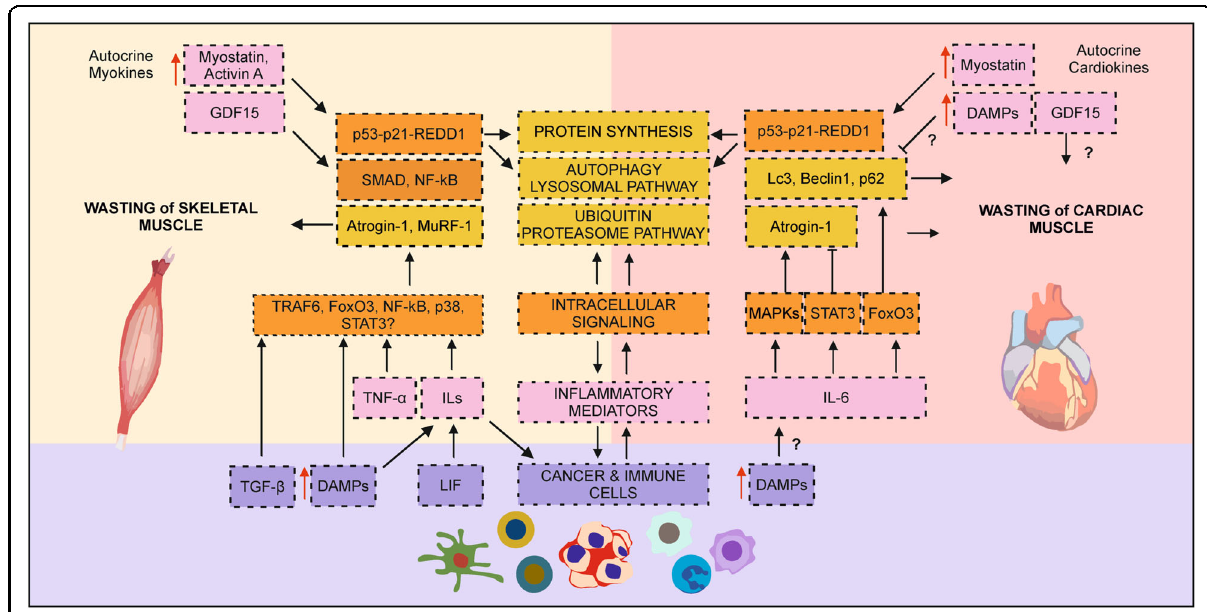
Fig. 2 Pathological alterations underlying muscle wasting in cancer cachexia. The mechanisms underlying cancer cachexia are multiple and intertwined. Either factors released by skeletal and cardiac muscles (myokines and cardiokines respectively; pink boxes) or factors secreted by cancer and cancer-associated immune cells (violet boxes) trigger a cascade of processes which ultimately result in cachexia. The circulating factors (pink), intracellular signaling pathways (orange), and fi nal effectors of wasting (yellow) that lead to skeletal (left side of the fi gure) and cardiac (right side of the fi gure) muscle wasting are reported. Albeit the biological processes underlying skeletal and cardiac muscle wasting are similar, their relative contribution and the speci fi c molecular players involved differ slightly. Red arrows indicate those factors that are increased as a consequence of chemotherapy. DAMPs damage-associated molecular patterns, GDF15 growth differentiation factor 15, ILs interleukins, LIF leukemia inhibitory Factor, TNF- α tumor necrosis factor alpha, TGF- β transforming growth factor